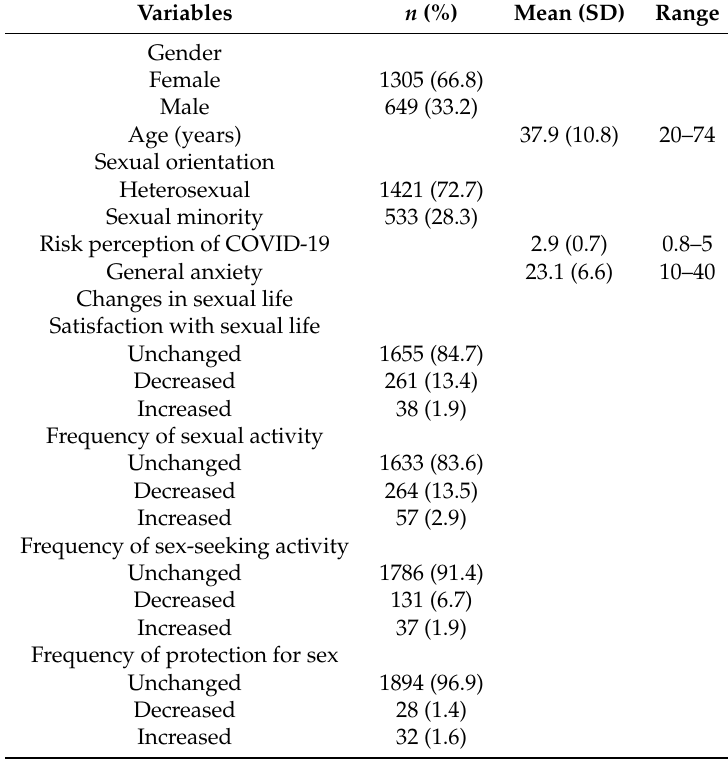
Table 1. Comparisons of Demographic Characteristics, Risk Perception of COVID-19, General Anxiety, and Changes in Sex Life Between Heterosexual and Sexual Minority Respondents ( N =